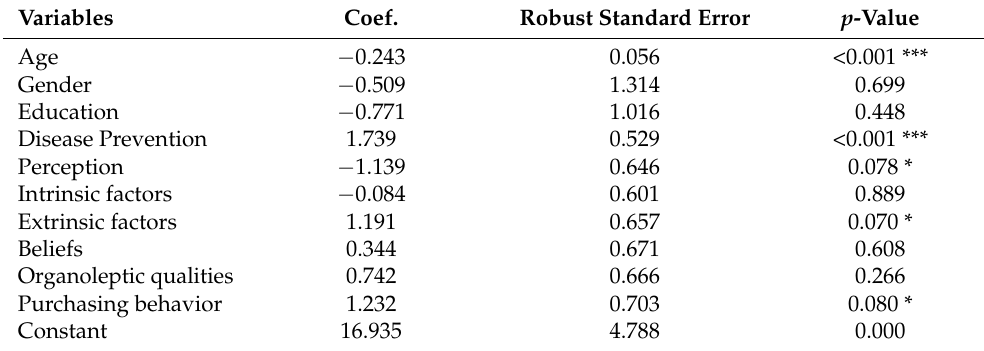
Table 3. OLS regression results.